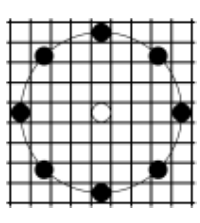
Figure 4. Example of neighborhood (black disks) for a pixel (central white disk) for LBP P , R code computation: in this case P = 8, R = 4.